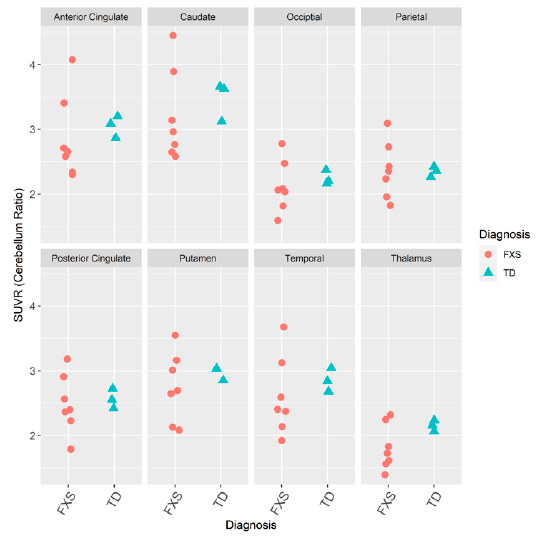
Figure 2. Dot plots of the ratio of densities of mGluR 5 in volumes of interest (VOIs) to whole cerebellum for participants from the Institute for Neurodegenerative Disorders (IND) with FXS ( N = 7) and TD ( N = 3) who received intravenous bolus injections of 185 MBqs (5 mCis) of [ 18 F]FPEB [55,79].